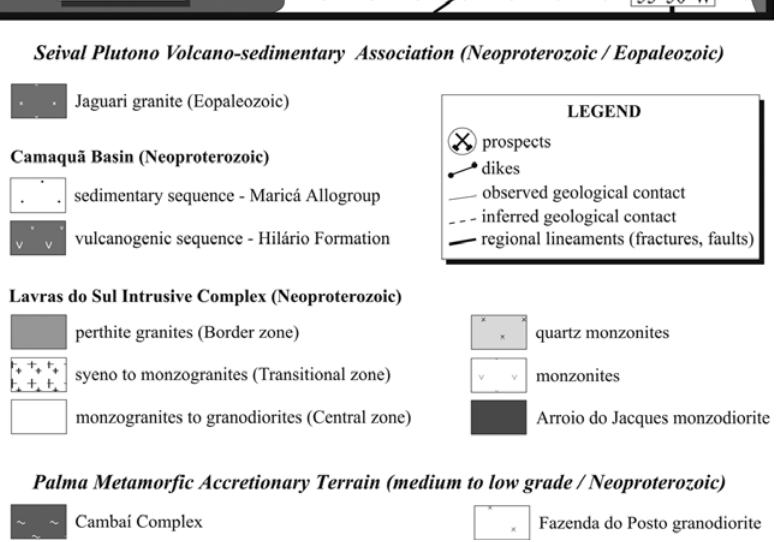
Fig. 1 – Simplified geological map of the Lavras do Sul region. Modified from Gastal and Lafon (1998). Sampling was performed in the following prospects: Bloco do Butiá (sample A), Cerrito (sample B), and Valdo Teixeira (samples C and